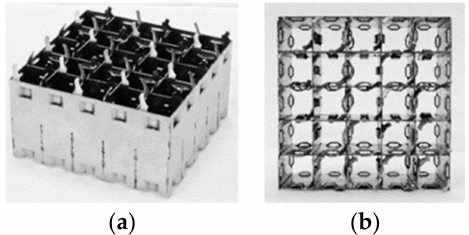
Figure 8. A 5 × 5 standard AFA-3G spacer grid: ( a ) the main view of the spacer grid and ( b ) the top view of the spacer grid.